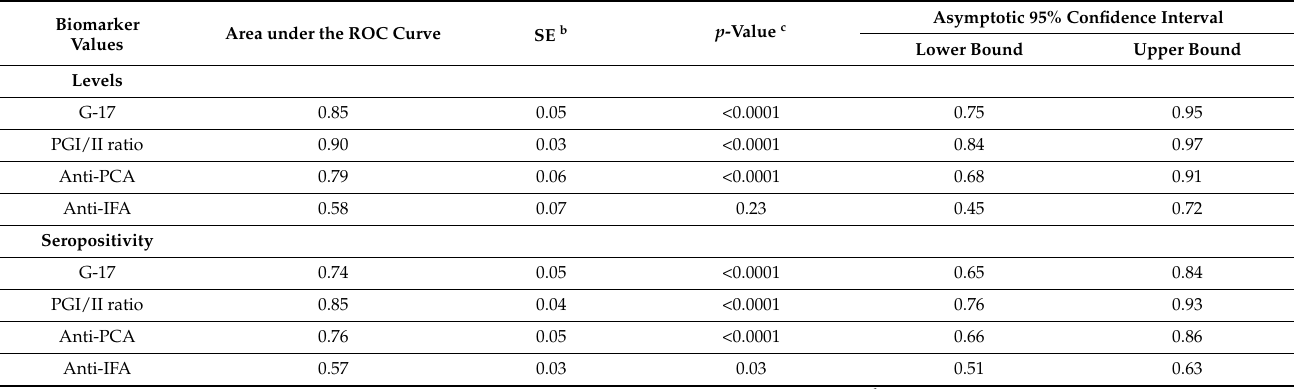
Table 4. Biomarker gastrin-17, anti-PCA, anti-IFA, and PGI/II ratio area under the ROC a curve results based on levels and category of seropositivity.